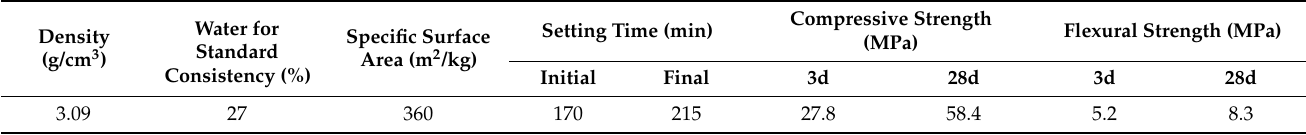
Table 1. Physical and mechanical properties of cement.